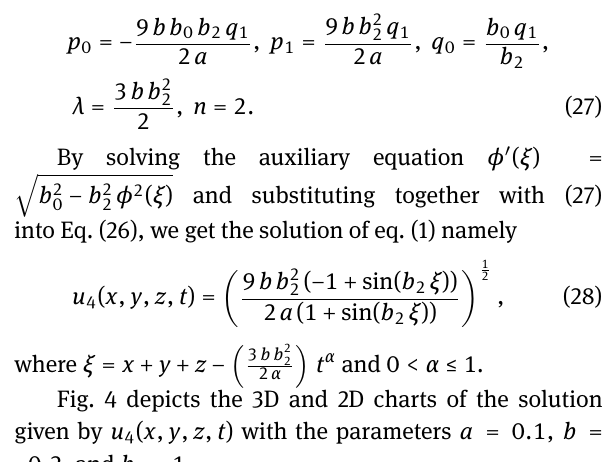
Fig.3depictsthe3Dand2Dchartsofthesolutiongiven by u ( x , y , z , t ) with the parameters a = 0.1, b = 0.2, and 3 k =